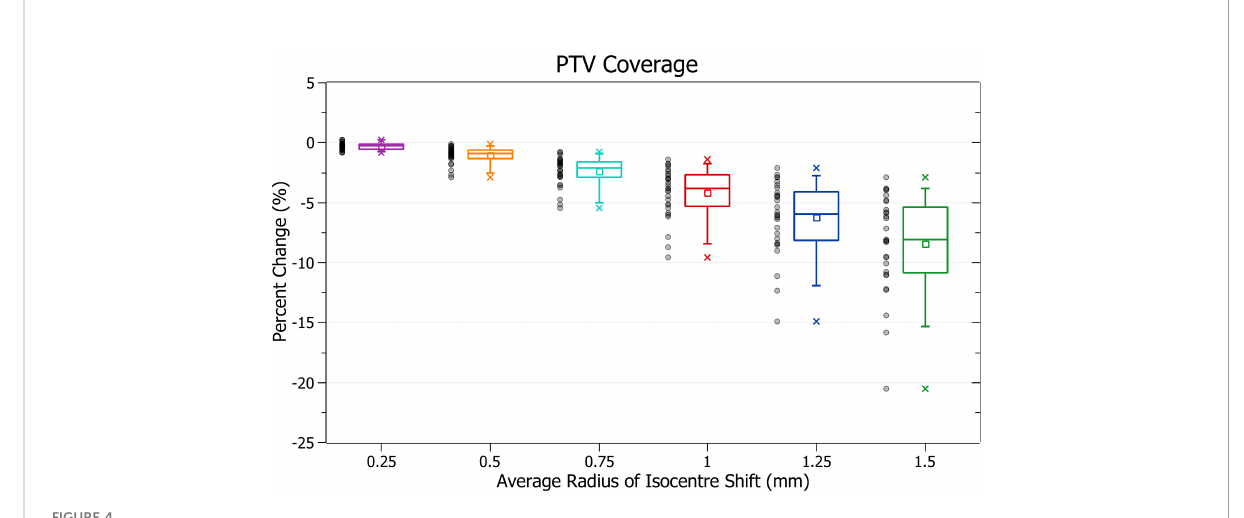
FIGURE 4 Percentage change of PTV coverage for different radii of isocentre shift.